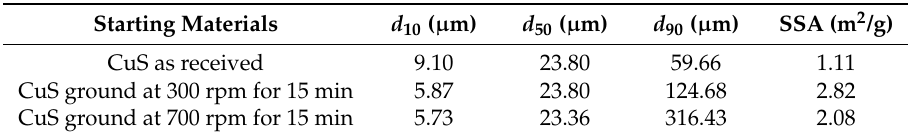
Figure 2. Particle size analysis profiles of CuS samples used as staring materials in this study. Table 1. Representative particle sizes and specific surface area (SSA) of three types of CuS used as the starting materials in this study.